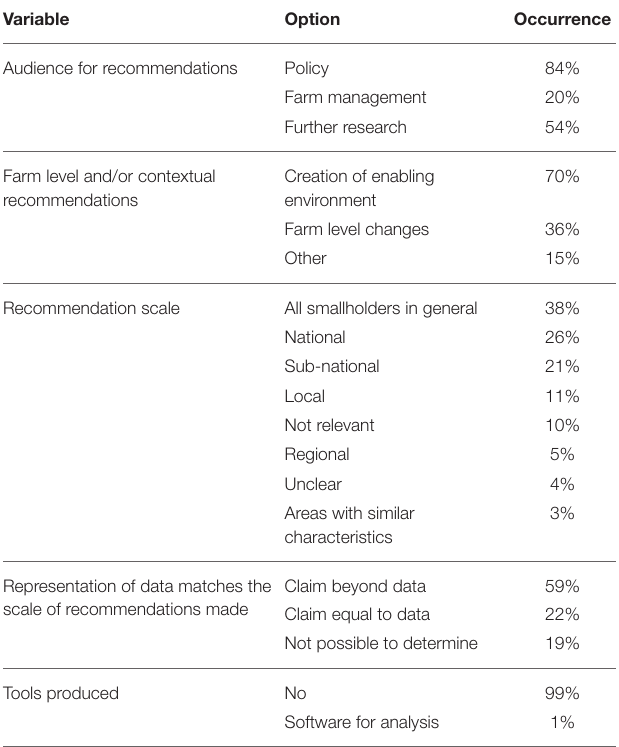
TABLE 6 | A summary of the types and scale of conclusions drawn, and the intended audience for the recommendations.